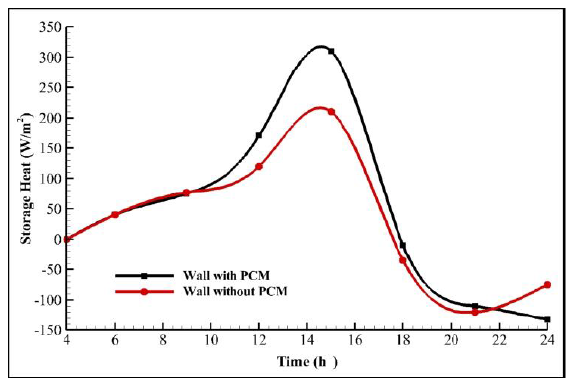
Figure 13. Heat flux through the external surface of the non ‐ PCM ‐ and PCM ‐ treated west walls. Energies 2016 , 9 , 30